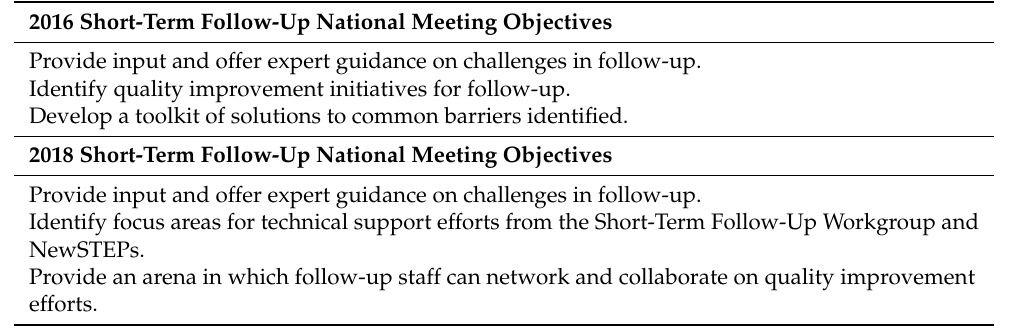
Table 2. NewSTEPs Short-Term Follow-Up national meeting